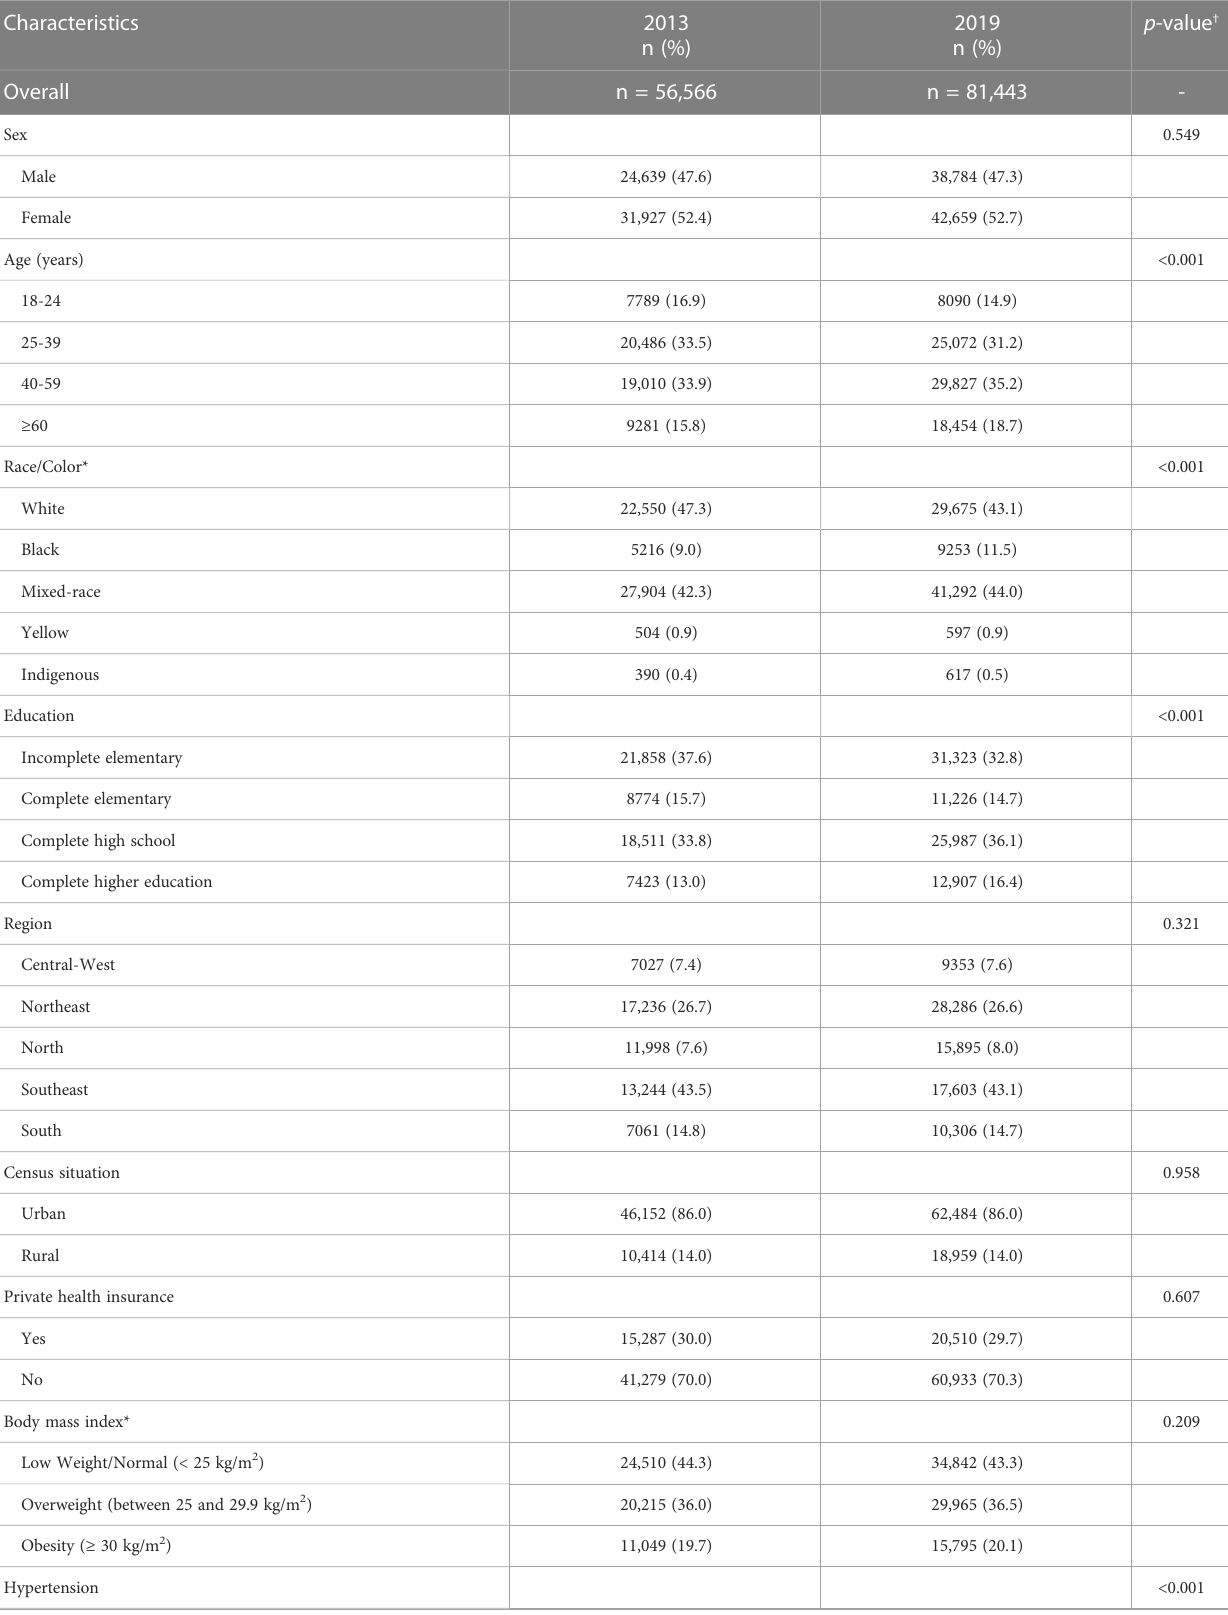
TABLE 1 Sociodemographic and clinical characteristics of participants, without diabetes diagnosis [n (weighted %)], in the Brazilian National Health Survey, 2013 and 2019 (n =